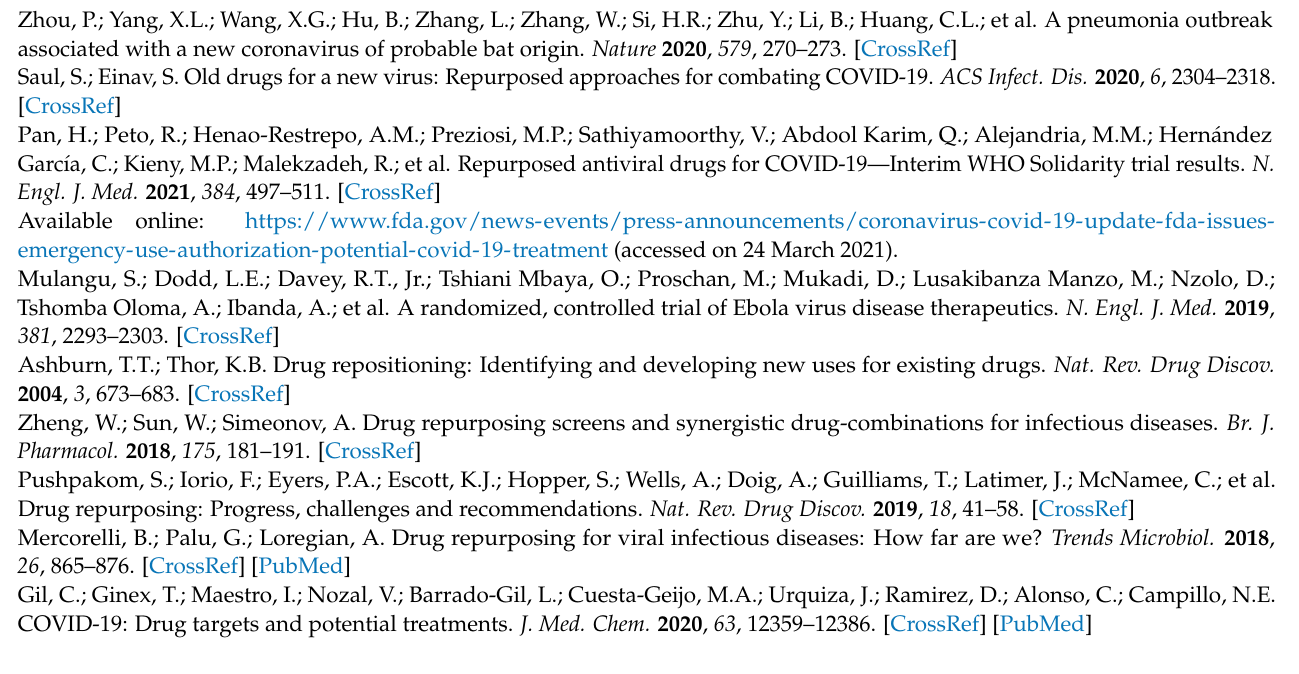
microscopy-based viral antigen detection, Figure S3: Evaluation of compound cytotoxicity. Table S1: Structural details about the eight targets analyzed in this study, Table S2: Clustering analysis of MD trajectories for S1-RBD and TMPRSS2, Table S3: Top ranked drugs from the FDA library by virtual screening, Table S4: Host-based target profile of compounds selected for biological evaluation on SARS-CoV-2 screen at 10 µ